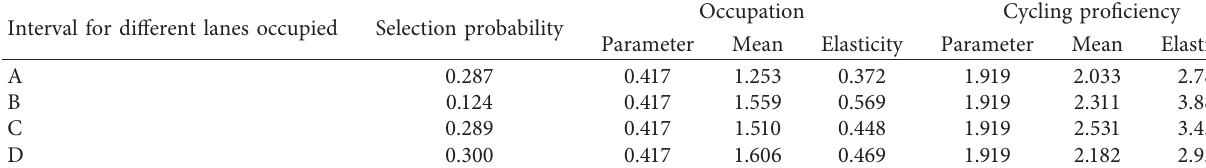
Table 12: Calculation results on occupation and cycling proficiency.